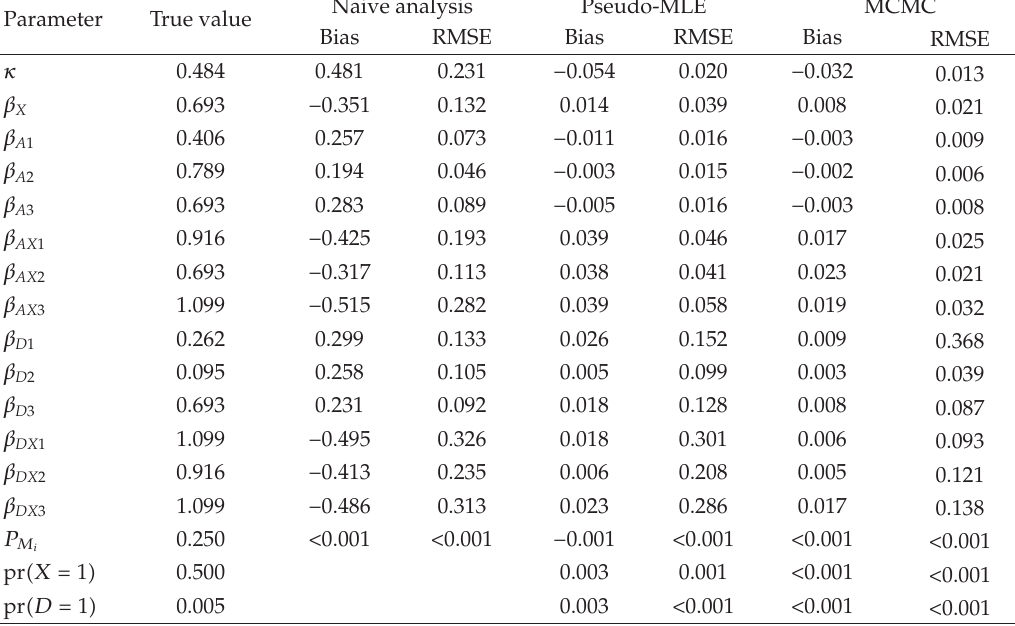
Table 1: Biases and root mean squared errors (cid:3) RMSEs (cid:4) of risk parameters for the naive approach that ignores existence of misclassification and the proposed method in the case when pr (cid:3) D (cid:7) 1 (cid:4) is known and when it is estimated. The results are based on 500 samples of 1,500 cases and 1,500 controls. Genotype is (cid:7) 0 . 25, i (cid:7) 1 , 2 , 3, with linkage disequilibrium corresponding to simulated at the three marker loci with P M i Δ (cid:7) 0 . 03. The environmental covariate (cid:3) X (cid:4) is binary and measured with error with misclassification M i M j probabilities being 0 . 20 for exposed and 0 . 25 for nonexposed subjects. The data is simulated and analyzed under the genotype e ff ect